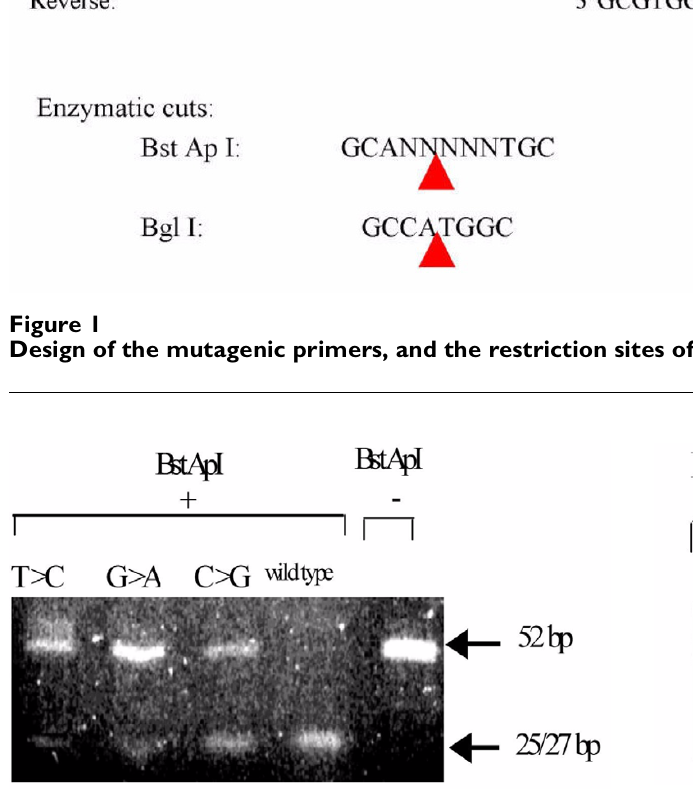
Figure 3 Check of the integrity of codon 634 with the Bgl I enzyme. DNA samples were amplified using forward and reverse primers shown in figure 1. The PCR product was incubated in the presence (lane 2–5) or absence (lane 1) of Bgl I. The restriction fragments were run in a non-denaturing 10% PAGE. Lane 1: wild type 634 codon without enzyme incubation ; lane 2: wild type 634 codon ; lane 3: mutation in the first base of the 634 codon (T>C); lane 4: mutation in the second base of the 634 codon (G>A); lane 5: mutation in the third base of the 634 codon (C>G). Both alleles are